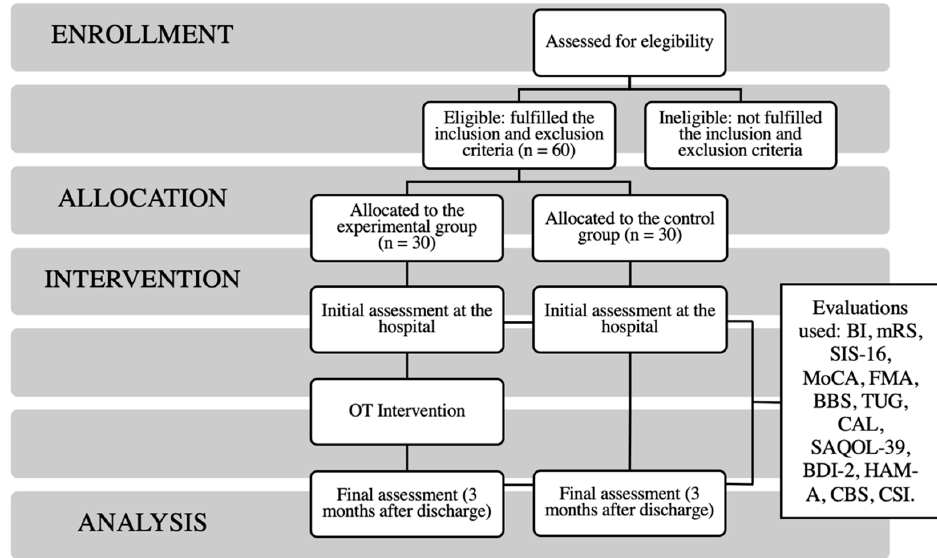
Figure 1. Protocol design implemented in the study.